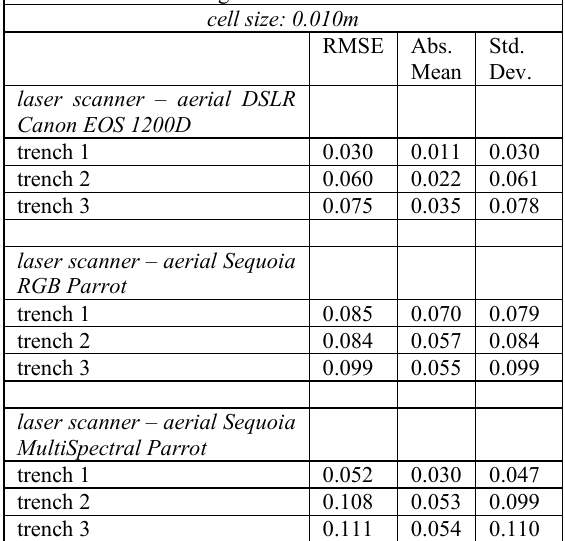
Table 5 . 3D model comparison between laser scanner and aerial image data of the first campaign (4/7/2019).